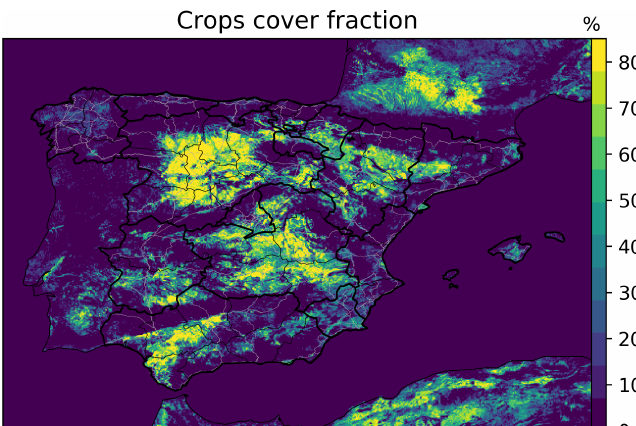
Figure G3. Crops land cover fraction.